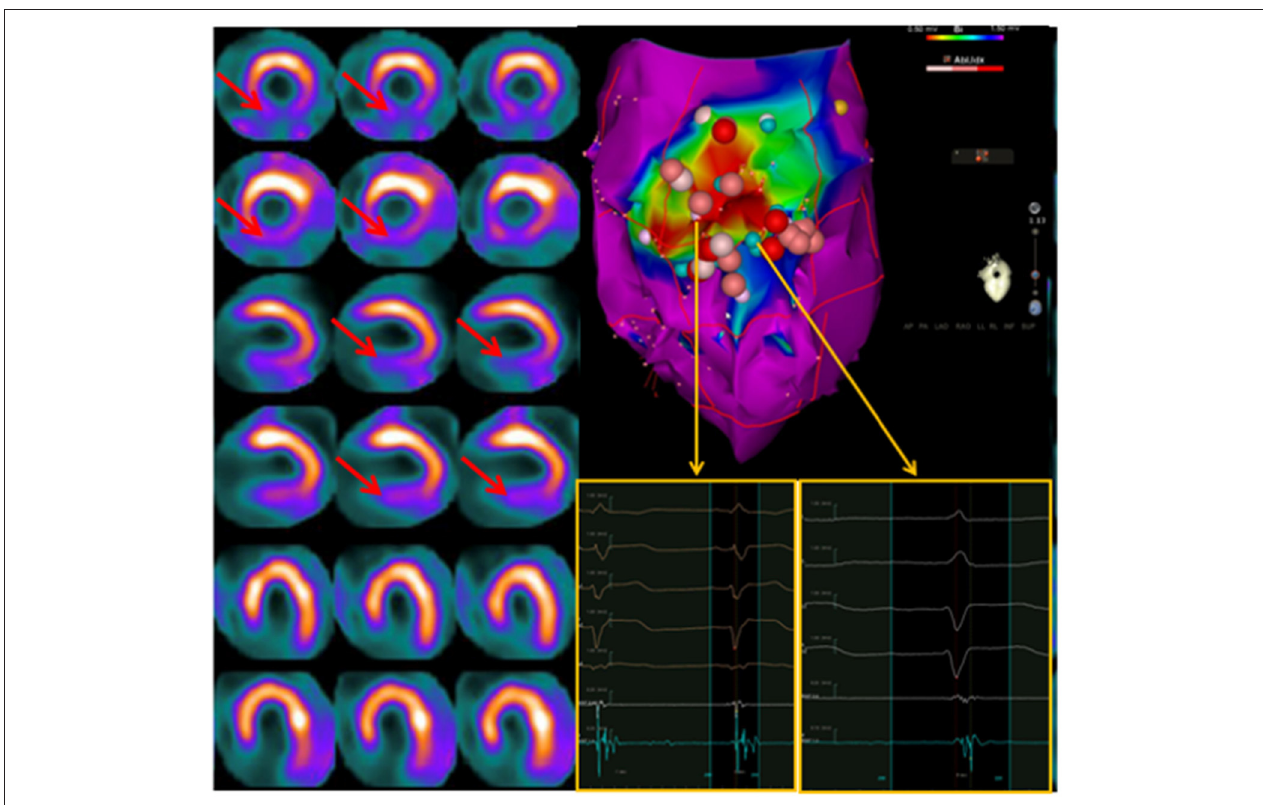
FIGURE 6 | Left: Interaction between endocavitary ablations and regional myocardial innervation ( 123 I-MIBG; top rows) and perfusion ( 99m Tc-tetrofosmin; bottom rows) parameters. Left: dual-tracer myocardial scintigraphy showing a basal inferior scar surrounded by a larger area of depressed sympathetic innervation (innervation/perfusion mismatch) in the mid-basal inferior and basal infero-lateral wall. Right: Left ventricle voltage map (inferior view) with correlation between perfusion/innervation mismatch and arrhythmic substrate, where the ablation was performed. On the side of the electrophysiological map are intracavitary signals of multichannel system (on light blue signals from ablation catheter). Adapted from Gimelli et al.